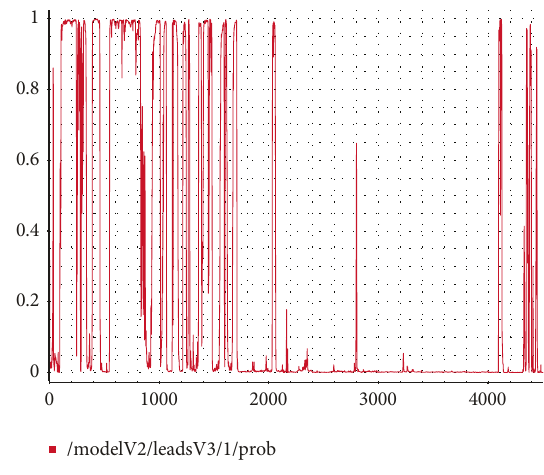
Figure 50: T2D3 lead car detection.